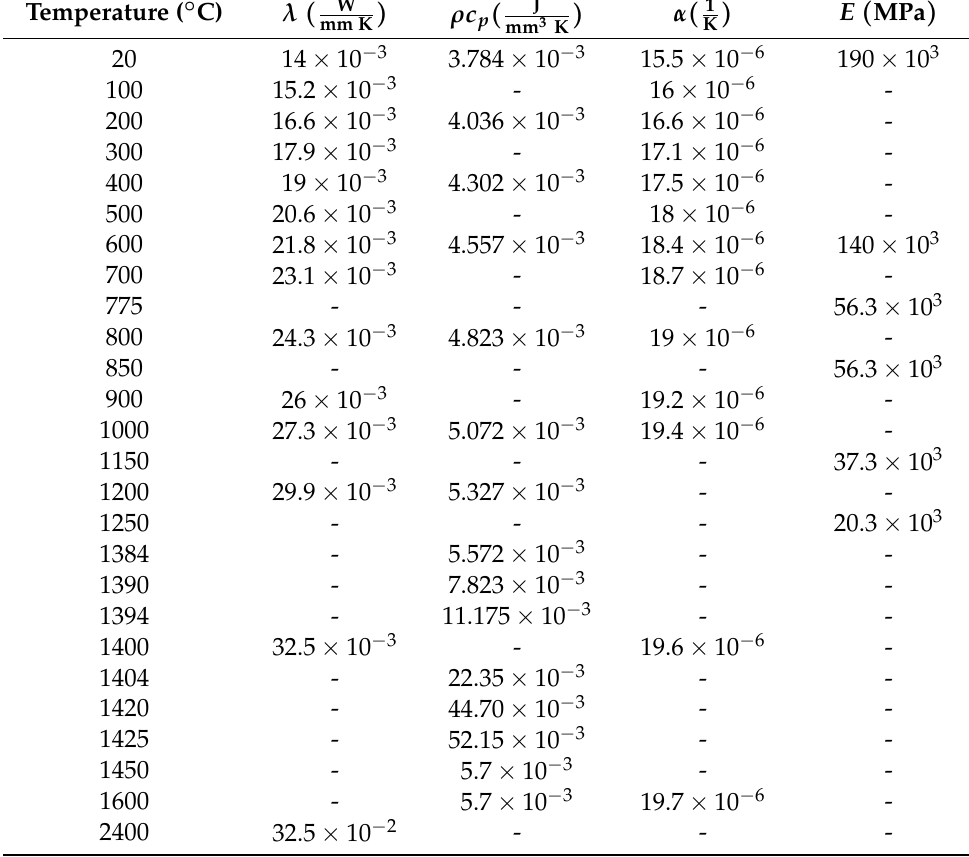
Table A2. Temperature dependent material parameters: thermal conductivity, volumetric heat capacity, thermal expansion coefficient and Young’s modulus.